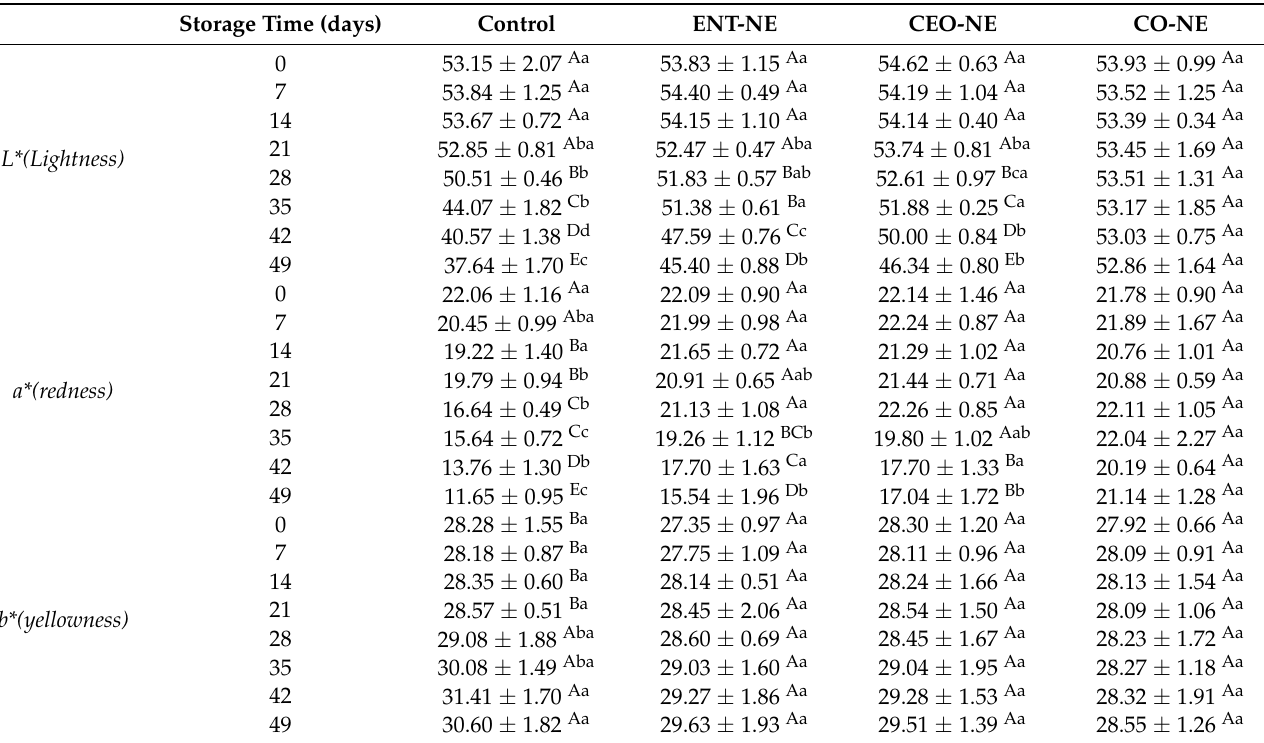
Table 4. Changes on instrumental color parameters (CIE L* , a* , b* ) of liquid-smoked salmon fillets treated with nanoemulsions containing enterocin Gr17 alone (ENT-NE), cinnamaldehyde alone (CEO- NE), enterocin Gr17 and cinnamaldehyde (CO-NE) and no enterocin Gr17/cinnamaldehyde (Control) during storage at 4 ◦ C for 49